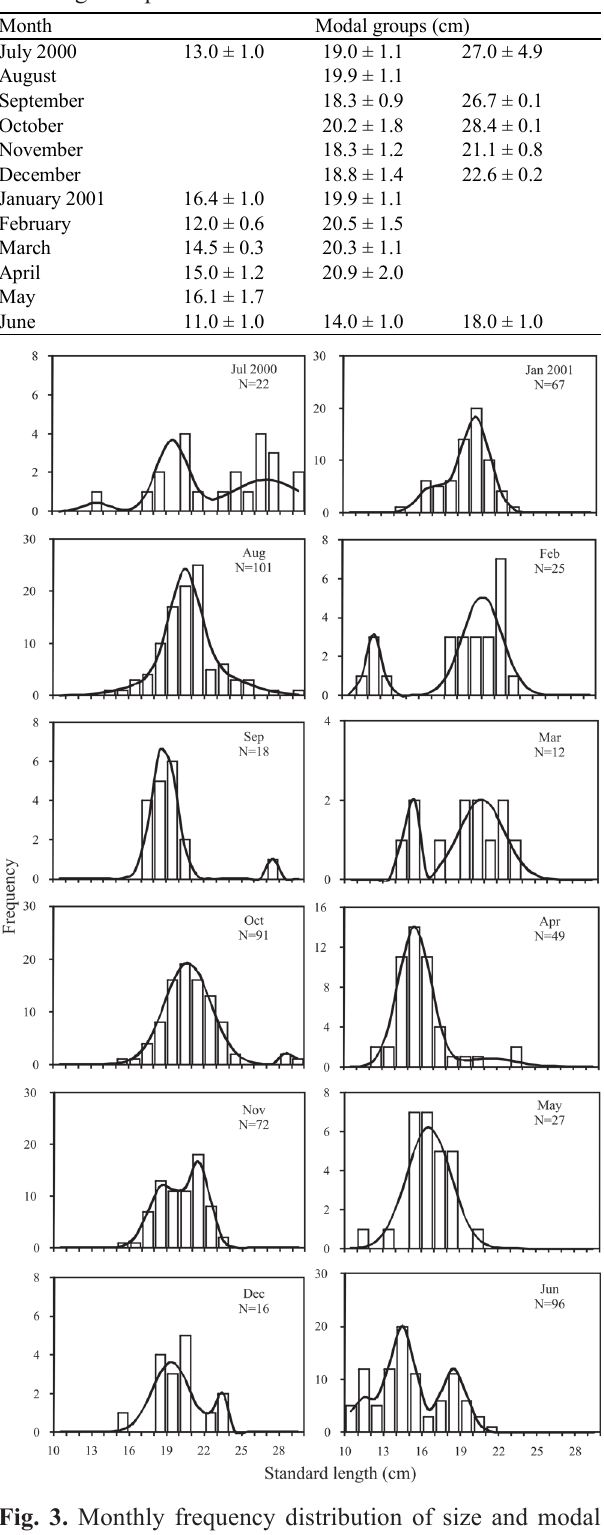
Table 1. Mean ± SD of the standard length of modal group estimates by month for the Sinaloa cichlid Cichlasoma beani in the Aguamilpa